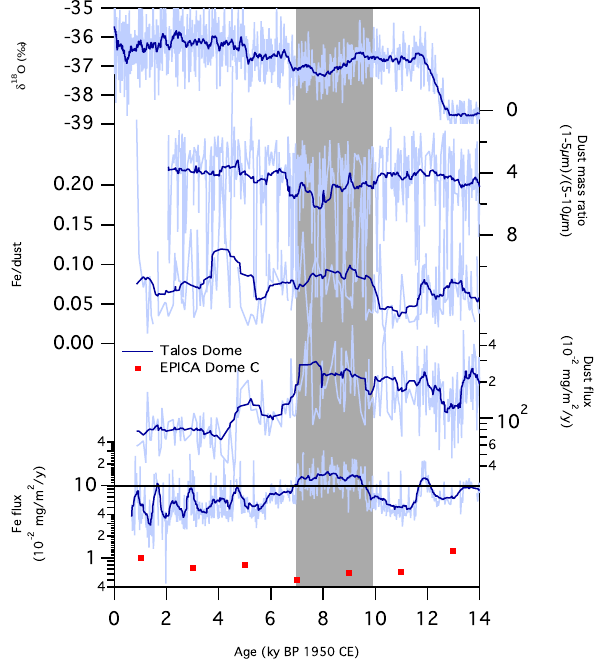
Fig. 3. Holocene Fe (this work) and dust (Delmonte et al., 2010) fluxes and fine (1–5µm)/coarse (5–10µm) dust particle ratios (Al- bani et al., 2012) in the TALDICE ice core (blue lines). TALDICE δ 18 O values are from (Stenni et al., 2011). EPICA Dome C dust fluxes (Wolff et al., 2006) are also shown (red squares). Note the fine/coarse dust particle ratios are plotted here on a reversed scale. The horizontal black line delineates the period of enhanced Fe fluxes from 7 to 10kyrBP.